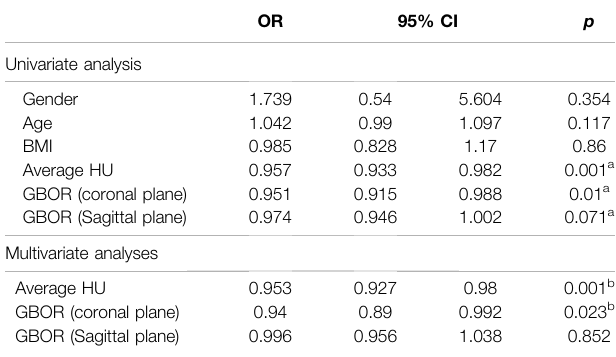
TABLE 5 | Logistic regression analysis of the caudal screw loosening.